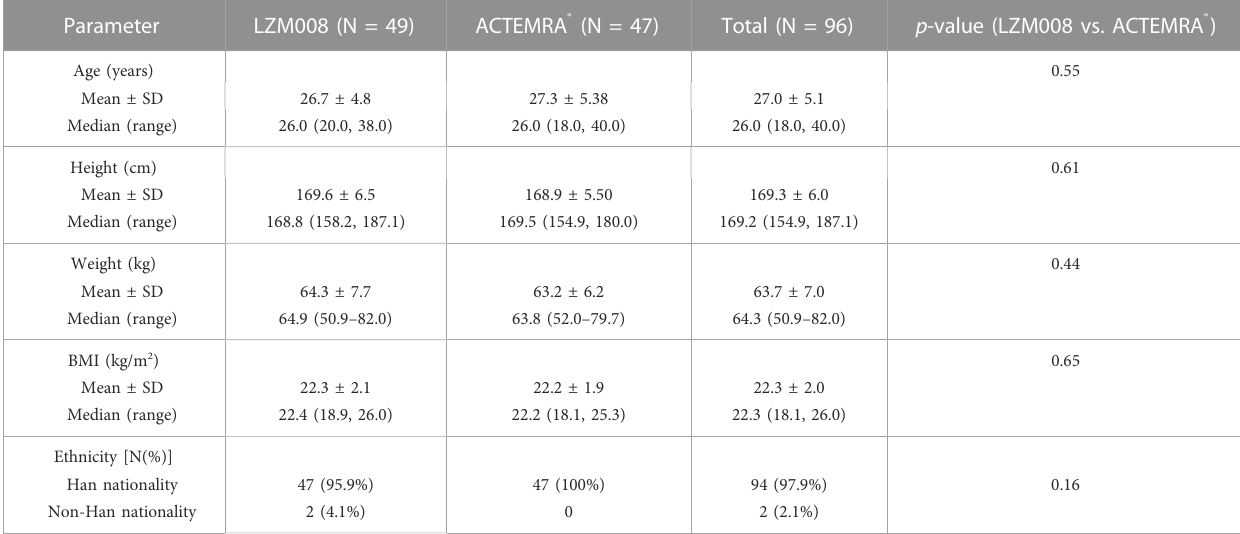
TABLE 1 Demographics and characteristics of